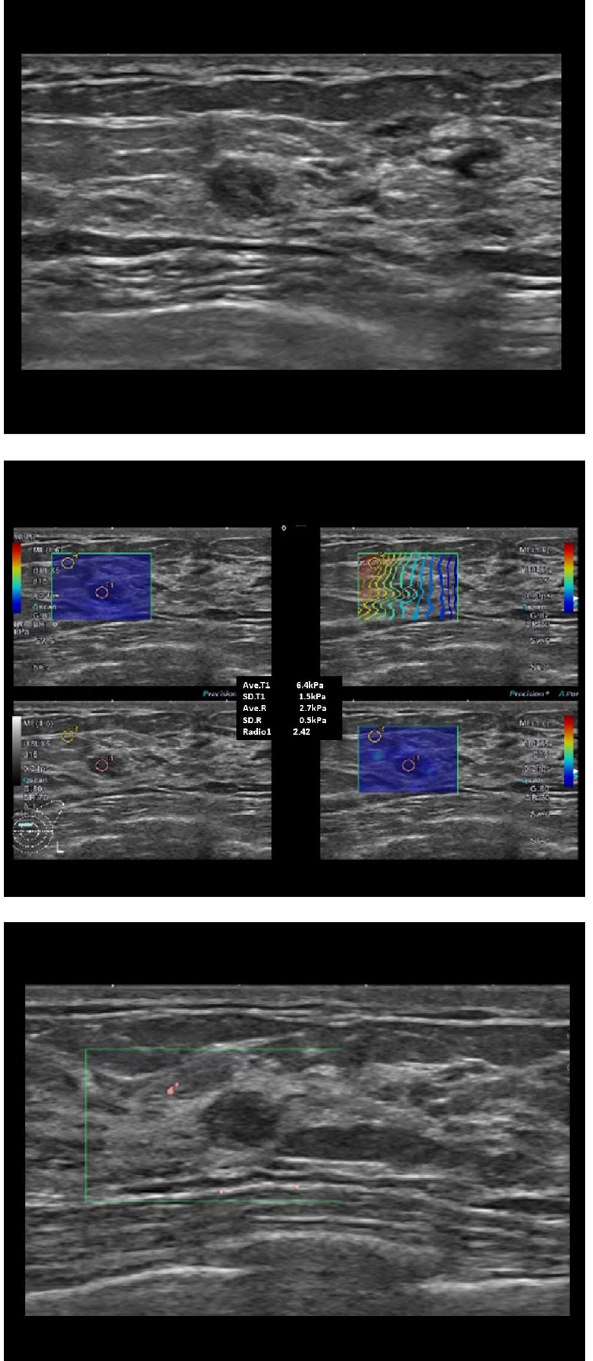
Figure 5. A 32-year-old female patient with fibroadenoma. ( A ) B-mode ultrasound showed a 0.6 cm-sized, mass categorized as C4a. ( B ) The SWEmax and SWE ratio were below the cutoff value as as SWEmax 6.4 kPa and SWEratio 2.42. ( C ) The vascular index of the SMI was 0%. The combined score was 2, indicating that the lesion was considered benign lesion. The pathologic diagnosis was